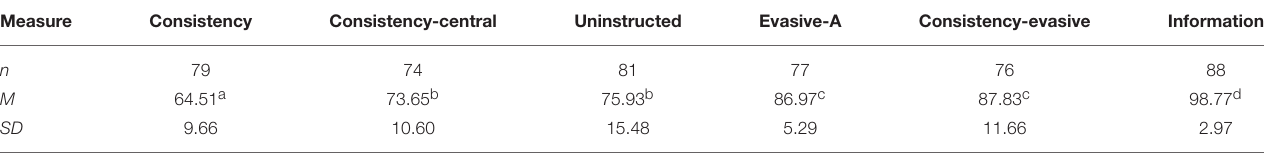
TABLE 1 | Sample size, mean accuracy rates, and standard deviations for the separate conditions in Experiment